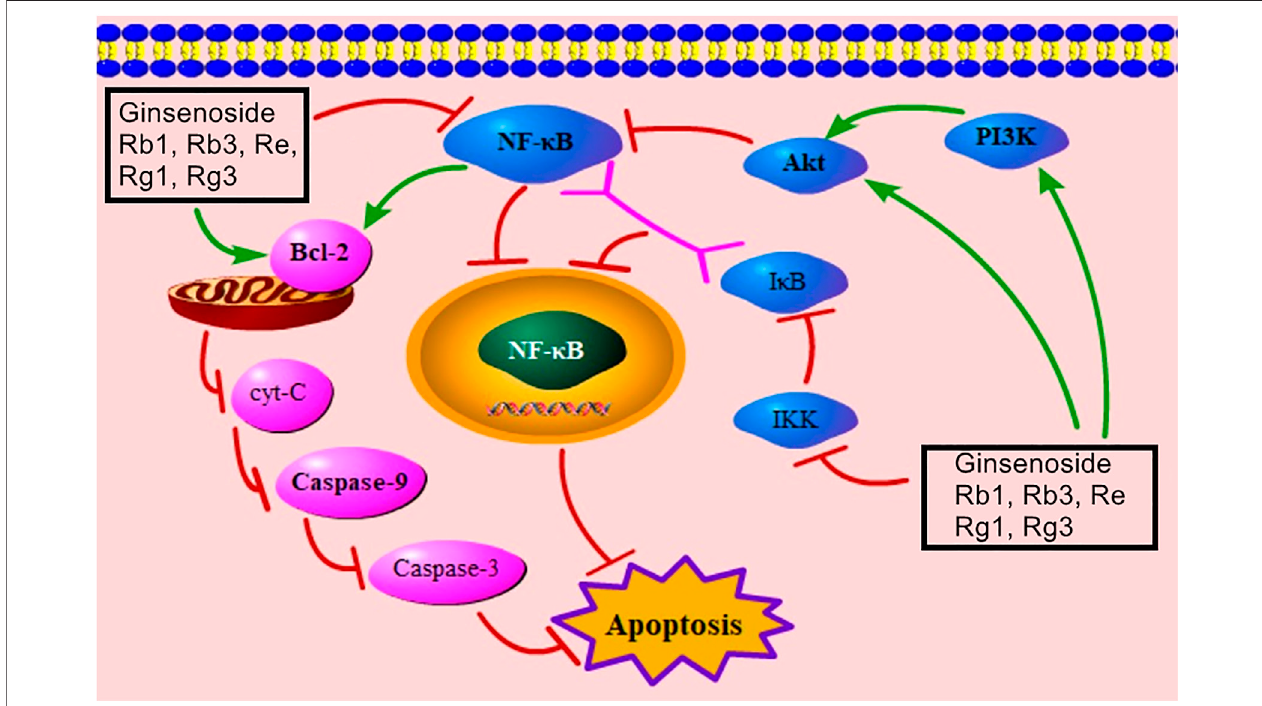
FIGURE 6 | NF- κ B – mediated signaling pathway of ginsenoside in relieving MC apoptosis. NF- κ B, nuclear factor of kappaB; cyt-C, cytochrome C; PI3K, phosphatidylinositol-3-kinase; I κ B, inhibitor of NF- κ B; IKK, I κ B kinase.